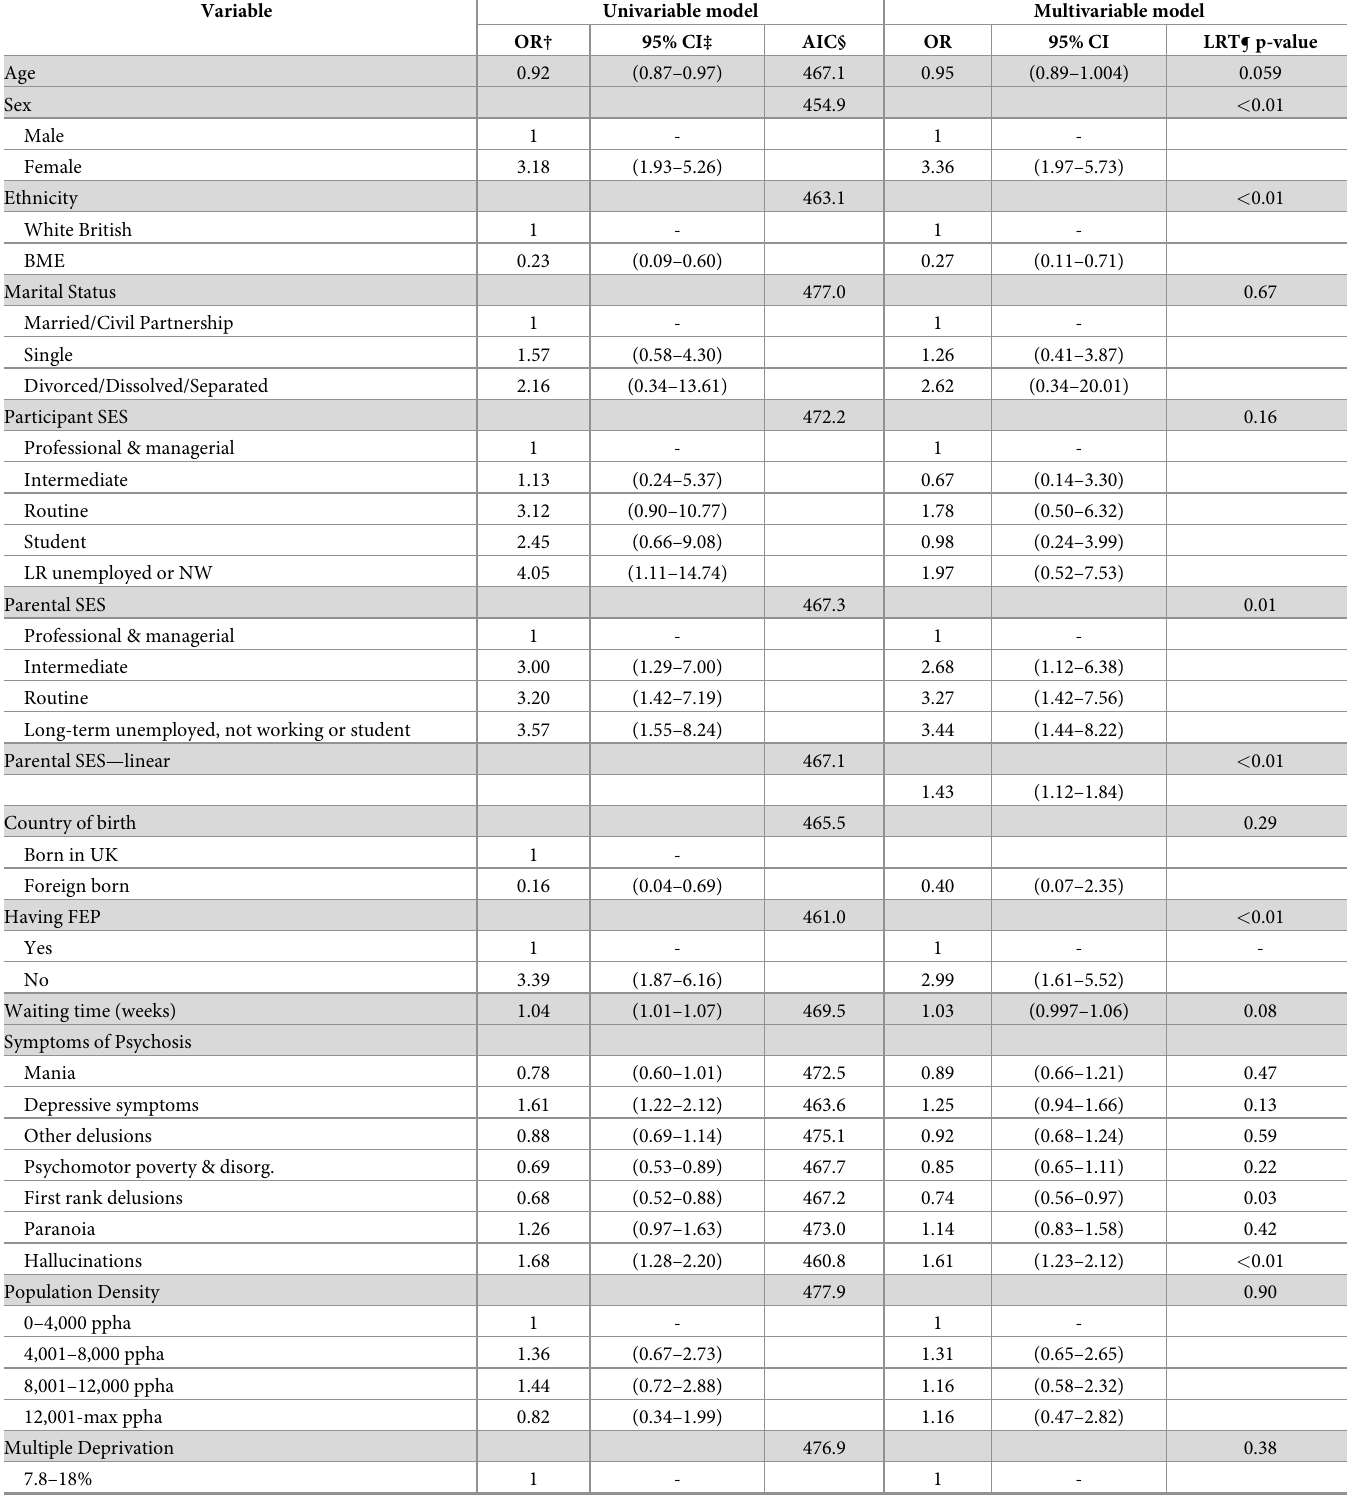
Table 2. Logistic regression models for predicting receiving a PD diagnosis in the EIP